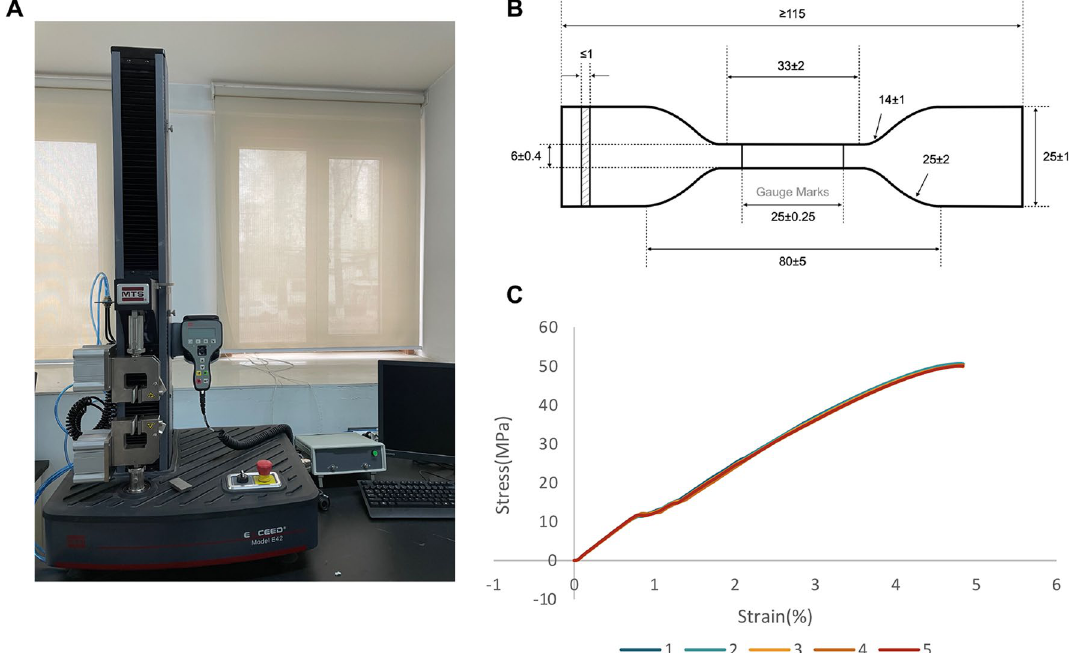
Fig. 2 Obtention of CA material parameters by in vitro experiment. A Mechanical universal testing machine. B Schematic of type A2 test specimen (dimensions in millimeters). C Stress–strain curve for nonlinear material properties of 0.75-mm-thick